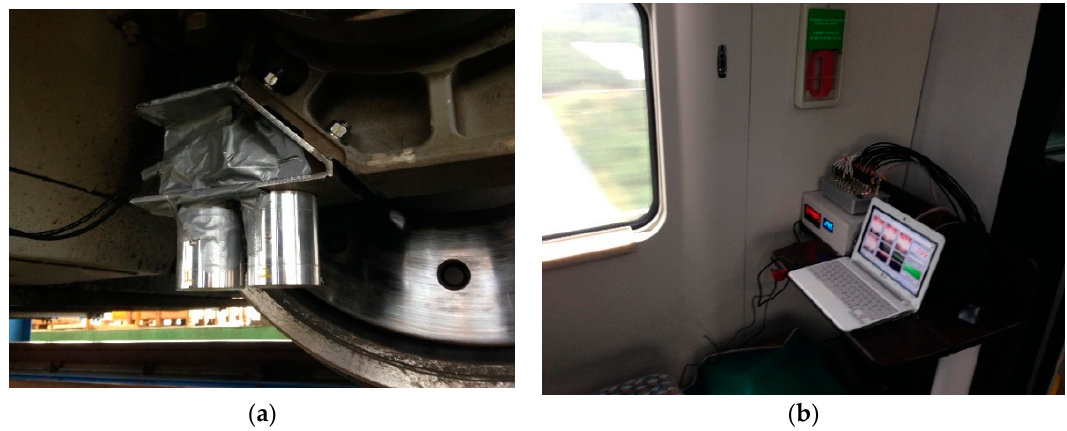
Figure 19. The VEH devices with the mechanical stopper for the high-speed train test: ( a ) the installation of two VEH devices on the axle box. Only the resonant frequencies were different from each other—one was 45 Hz, and the other was 50 Hz; ( b ) the voltage measurement system in the cabin.